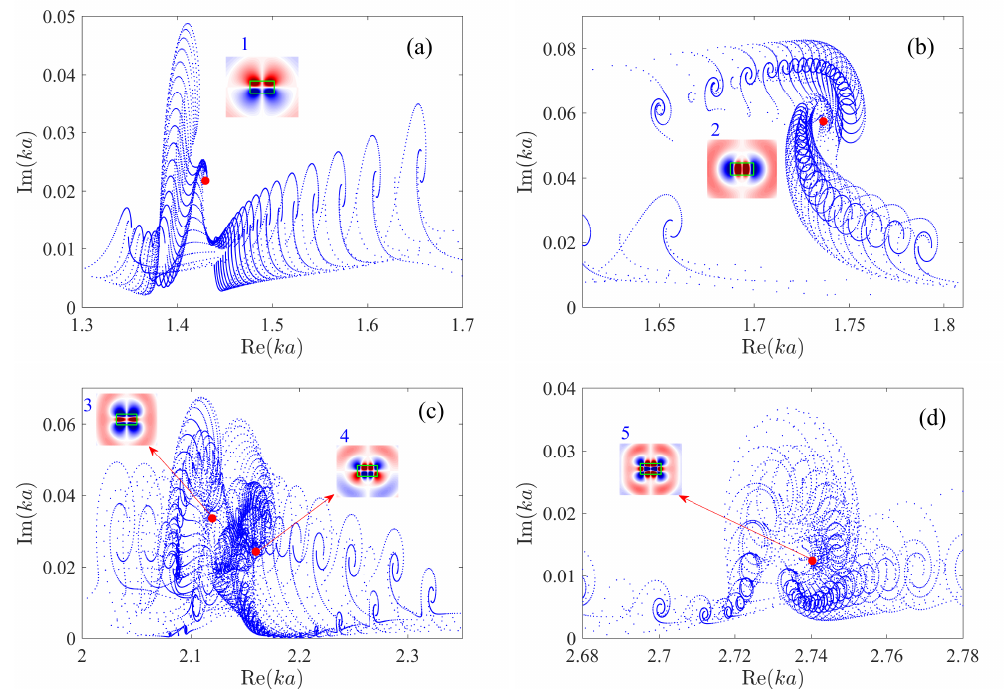
Figure 3. ( a – d ). Evolution of resonant frequencies of four disks for variation of two distances: the distance between dimers 0.05 ≤ L ≤ 4 and the distance between disks in each dimer 0.05 ≤ D ≤ 4. Red closed circles mark the eigenfrequencies of single